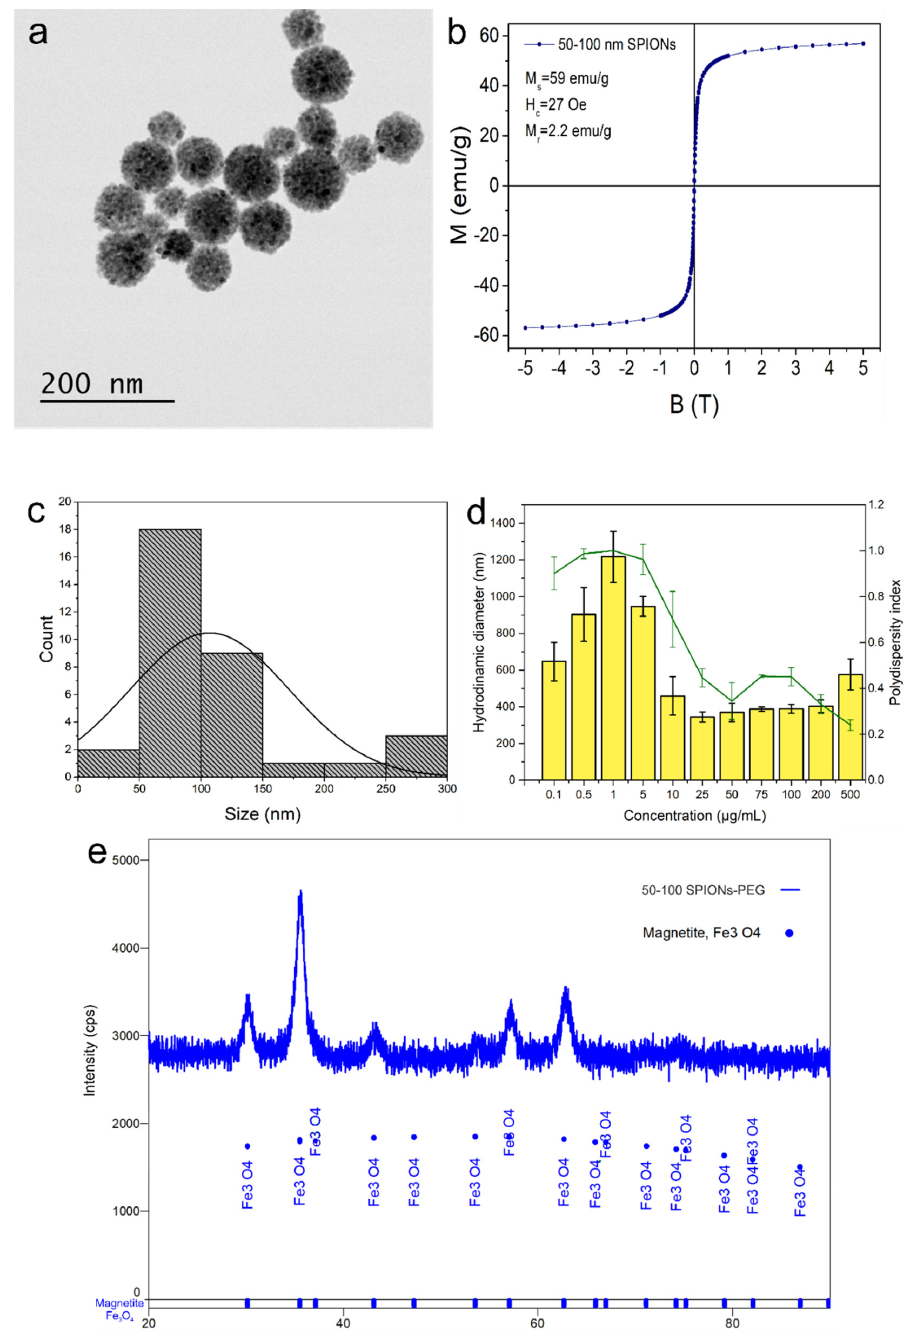
Figure 1. TEM micrograph of the obtained SPION-PEG clusters ( a ), with the magnetization curves versus applied magnetic field at room temperature ( b ), their size distribution ( c ), and hydrodynamic diameter as determined through dynamic light scattering ( d ). XRD pattern of the resulted SPION-PEG clusters and compared to P.D.F. card 01-076-7165 of magnetite ( e ).